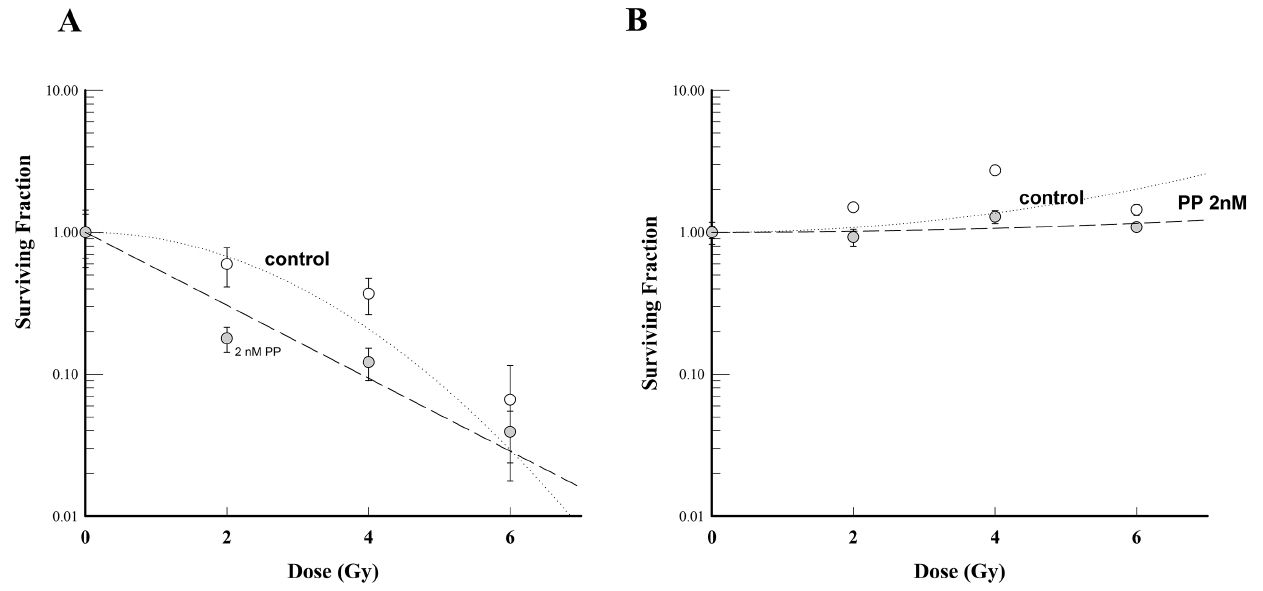
Figure 8. PP sensitized SUM-149 cells to radiation therapy. SUM-149 cells cultured in normal media were treated without or with 2 nM PP for 96 hours, followed by treatment with the indicated dose of radiation. Then cells were trypsinized and seeded in mammosphere media (A) or monolayer media (B). The results are representative of at least three independent experiments.